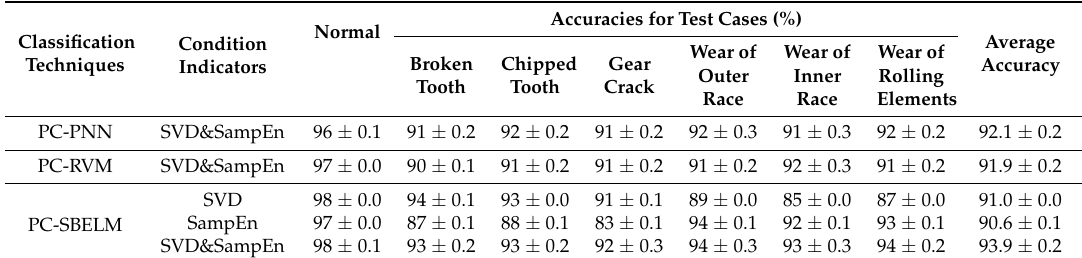
Table 8. Evaluation results of proposed PC-SBELM with pairwise-coupled probabilistic neural network (PC-PNN) and pairwise-coupled relevance vector machine